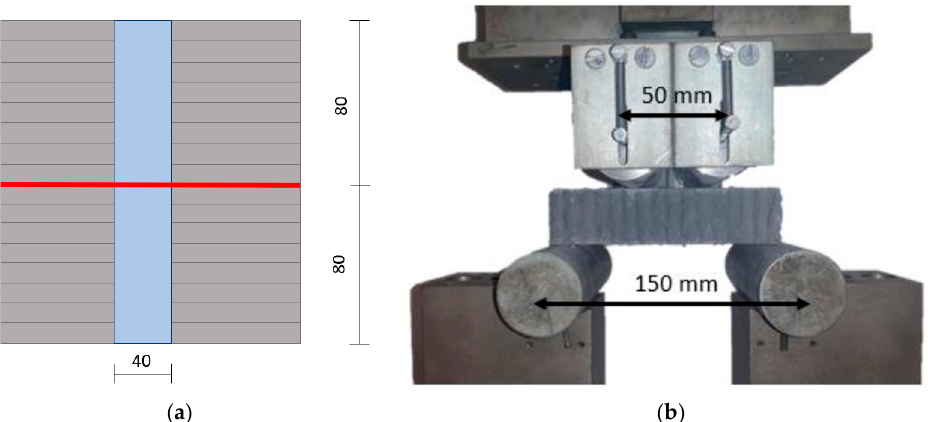
Figure 3. ( a ) Extraction of the 3D printed flexural strength sample (blue) with the CL indicated in red. ( b ) Four-point bending in the O-III orientation to determine the IBS.